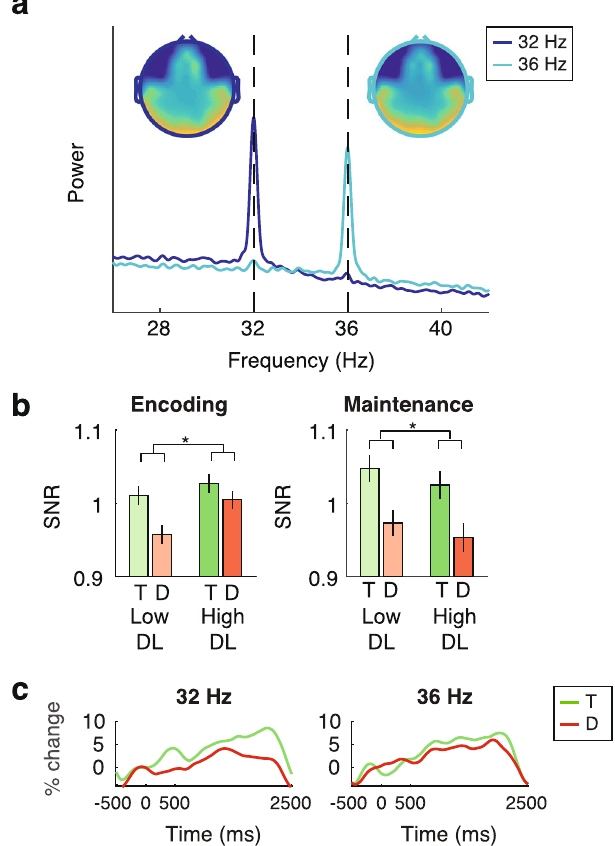
Figure 4. SSVEP responses at the second harmonic. ( a ) Frequency spectrum and topography of the RESS time series optimized for the second harmonics of the SSVEP at 32 (dark blue) and 36 (light blue) Hz, computed using the condition-average data in the time-window during which the flickering placeholders were on screen and the SSVEP was stable ( − 500 to 2500 ms), using the condition-average data (the y-axis reflects arbitrary power units as the RESS time series were computed based on multivariate source separation). The average topographies of the two frequencies show strong overlap, but differ from the topographies of the SSVEP at the fundamental frequency (see Figure 3a). The frequency spectra show distinct differences between the two RESS time series in terms of their frequency content. ( b ) SSVEP response (computed as the normalized SNR) for target (T; green) and distractor (D; red) locations. SSVEP responses were stronger at target compared to distractor locations during both VSTM encoding and maintenance. Distractor load (DL; low vs. high; light vs. dark shades respectively) did not affect SSVEP power. ( c ) Time course of the SSVEP, displayed as the % change in activity relative to the baseline ( − 200 to 0 ms), for the target (green) and distractor (red) locations at 16 Hz (left panel), and 18 Hz (right panel). The time course was obtained via the Hilbert transform of the bandpass filtered RESS time series (FWHM 3 Hz) for each frequency and condition (targets and distractor locations). Prior to baseline normalization, for each time point, the bandpass-filtered and Hilbertized power at the neighboring frequencies (spaced ± 2, 2.5, 3 Hz distance) was subtracted from the power at the frequencies of interest (similar to the computation of the SSVEP response shown in b ). Error bars represent the standard error of the